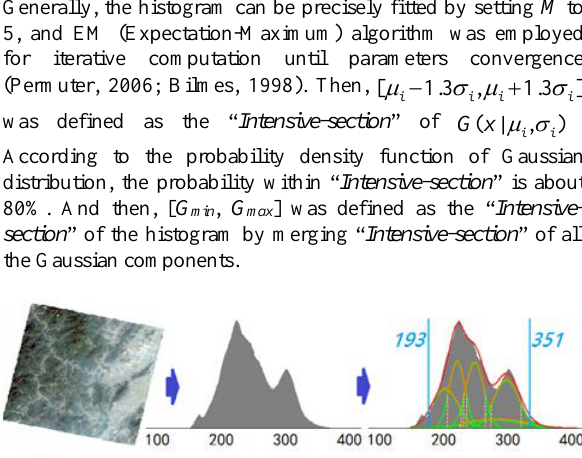
Figure 2. Otsu thresholds and qualifications (from top to bottom: blue, green and red band) In figure 2, Otsu thresholds O were represented as red